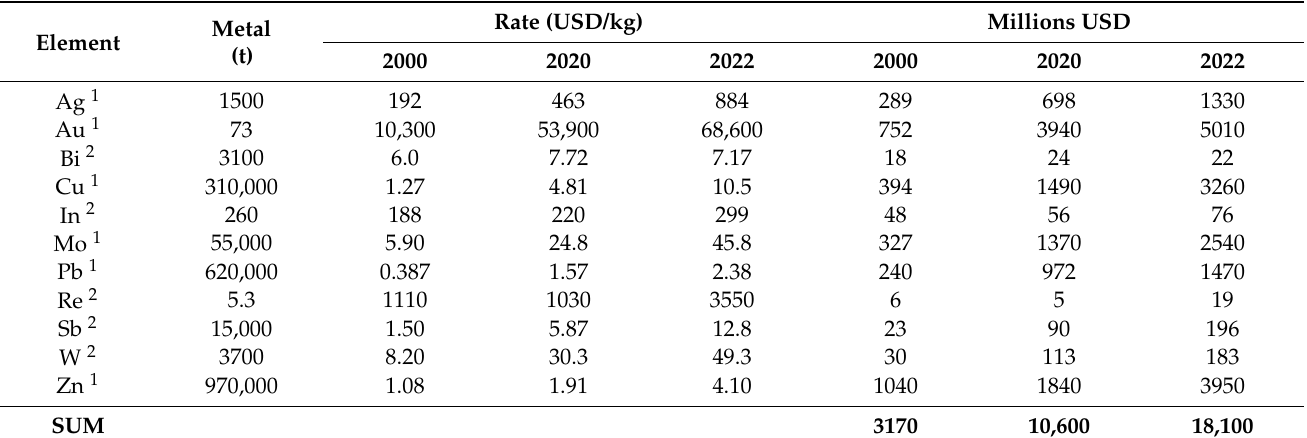
Table 4. Metal rates and values for selected chemical elements according to the years 2000, 2020, and